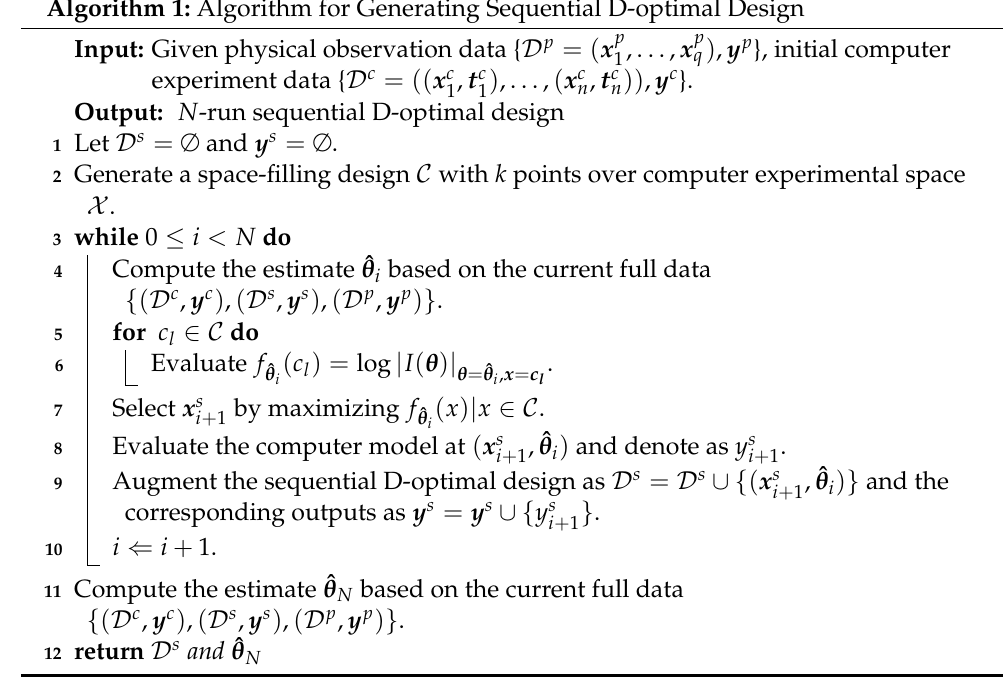
Algorithm 1: Algorithm for Generating Sequential D-optimal